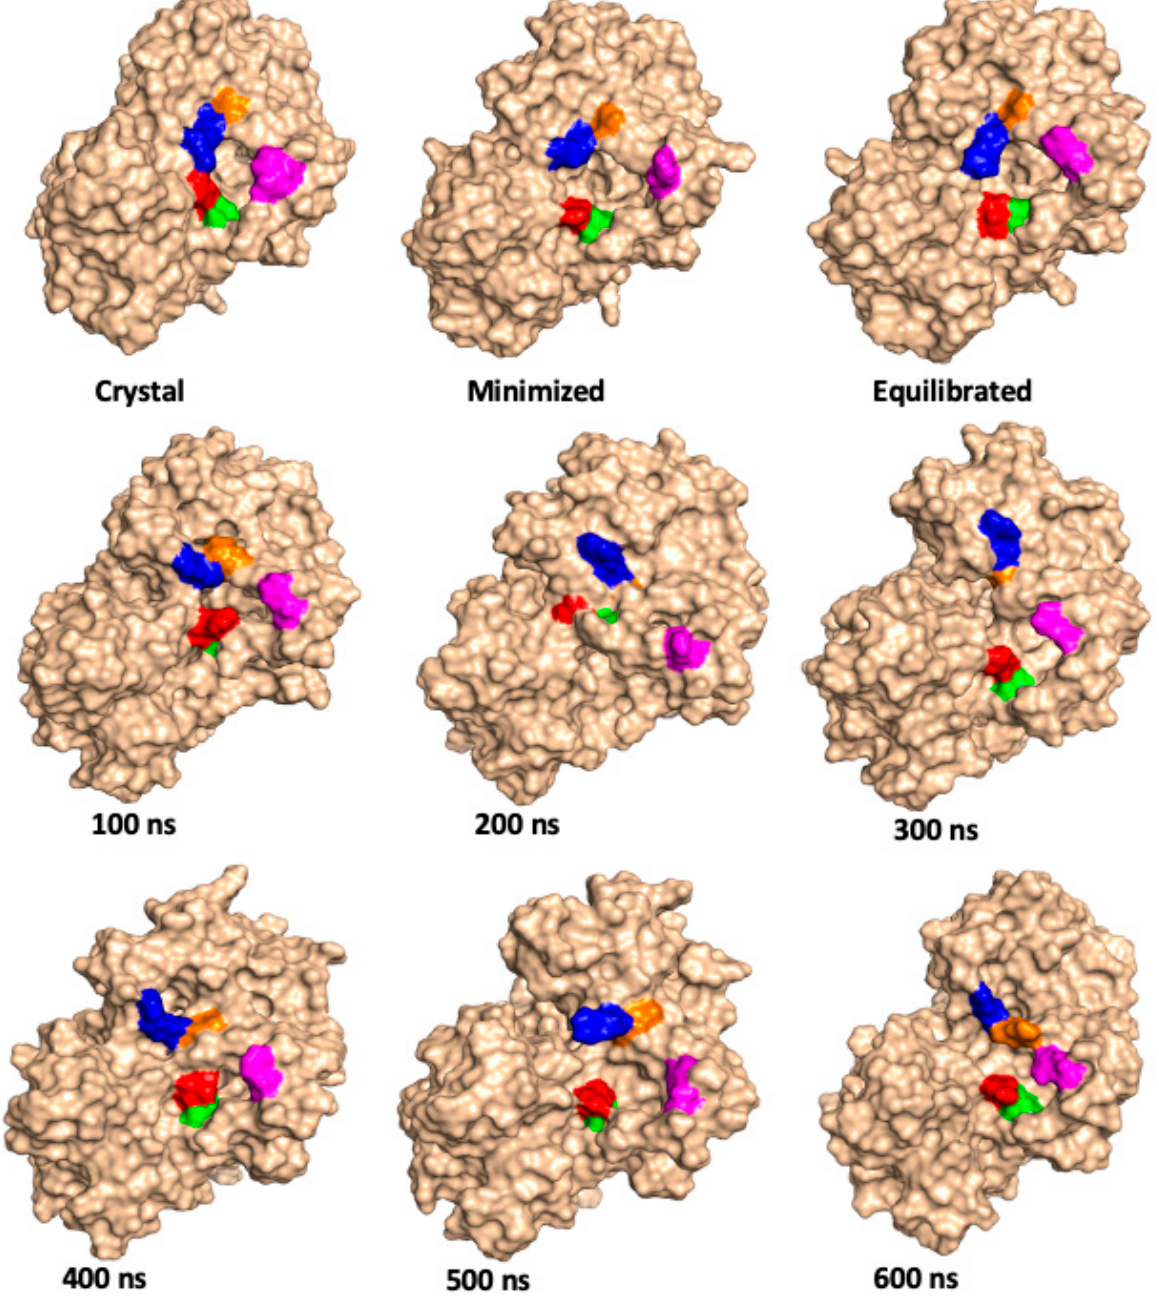
Figure 6. Illustration of the position of selected hydrophilic residues of the P450-TT enzyme involved in the substrate channel, as observed in the X-ray crystal structure, minimized and equilibrated structures (see Methods), and at periodic times during the 600.5 ns MD simulations, performed at 333 K. Color code: Gln66 = red; Ser67 = green; Arg76 = magenta; Arg88 = blue, and Asn87 = orange.